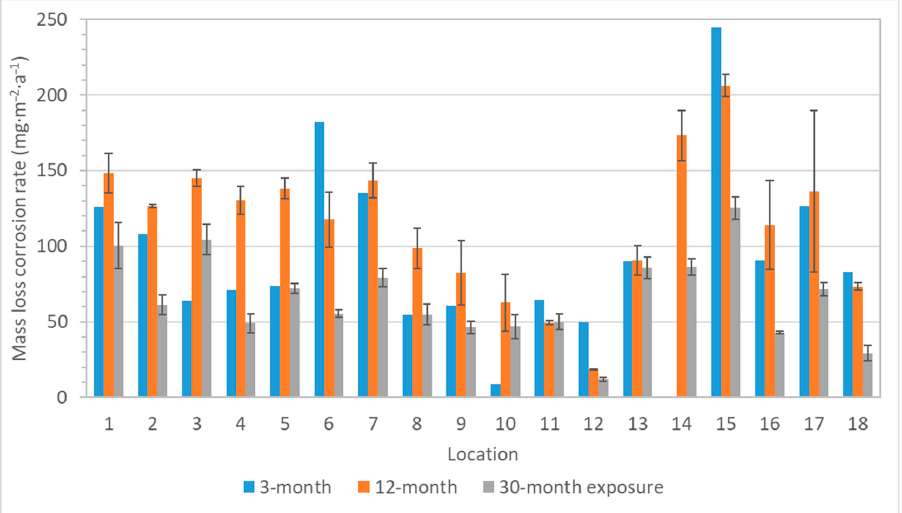
Figure 11. Corrosion rate calculated from mass loss of silver coupons (error bars for 3-month exposure are missing due to the small number of exposed samples).